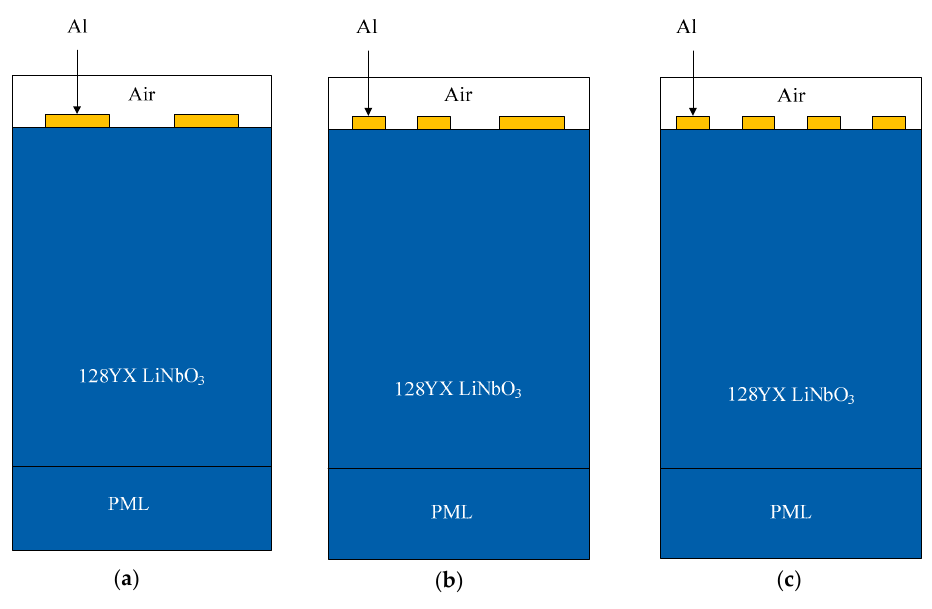
Figure 6. FEM models for the three types IDTs: ( a ) bidirectional IDT, ( b ) EWC/SPUDT, and ( c ) split IDT.